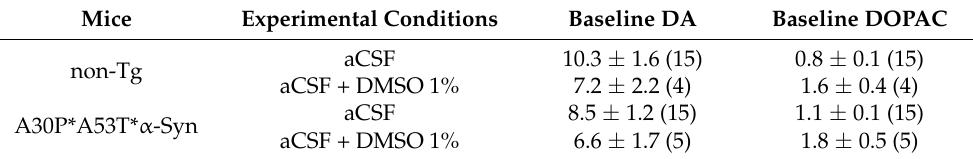
Table 1. Baseline DA and DOPAC dialysate concentrations in the CPu of mice.